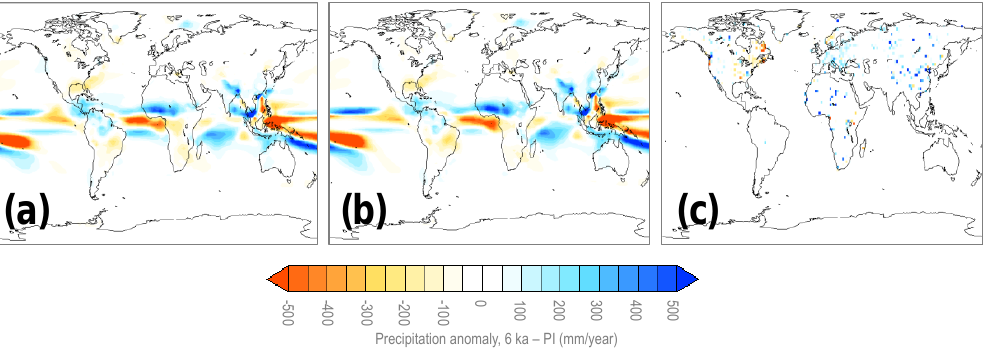
Figure 15. Mid-Holocene minus pre-industrial precipitation anomalies: (a) annual mean precipitation anomalies from the control exper- iment; (b) annual precipitation anomalies from the KK10 experiment; (c) Bartlein et al. (2011) pollen-based reconstructions of the mean annual precipitation